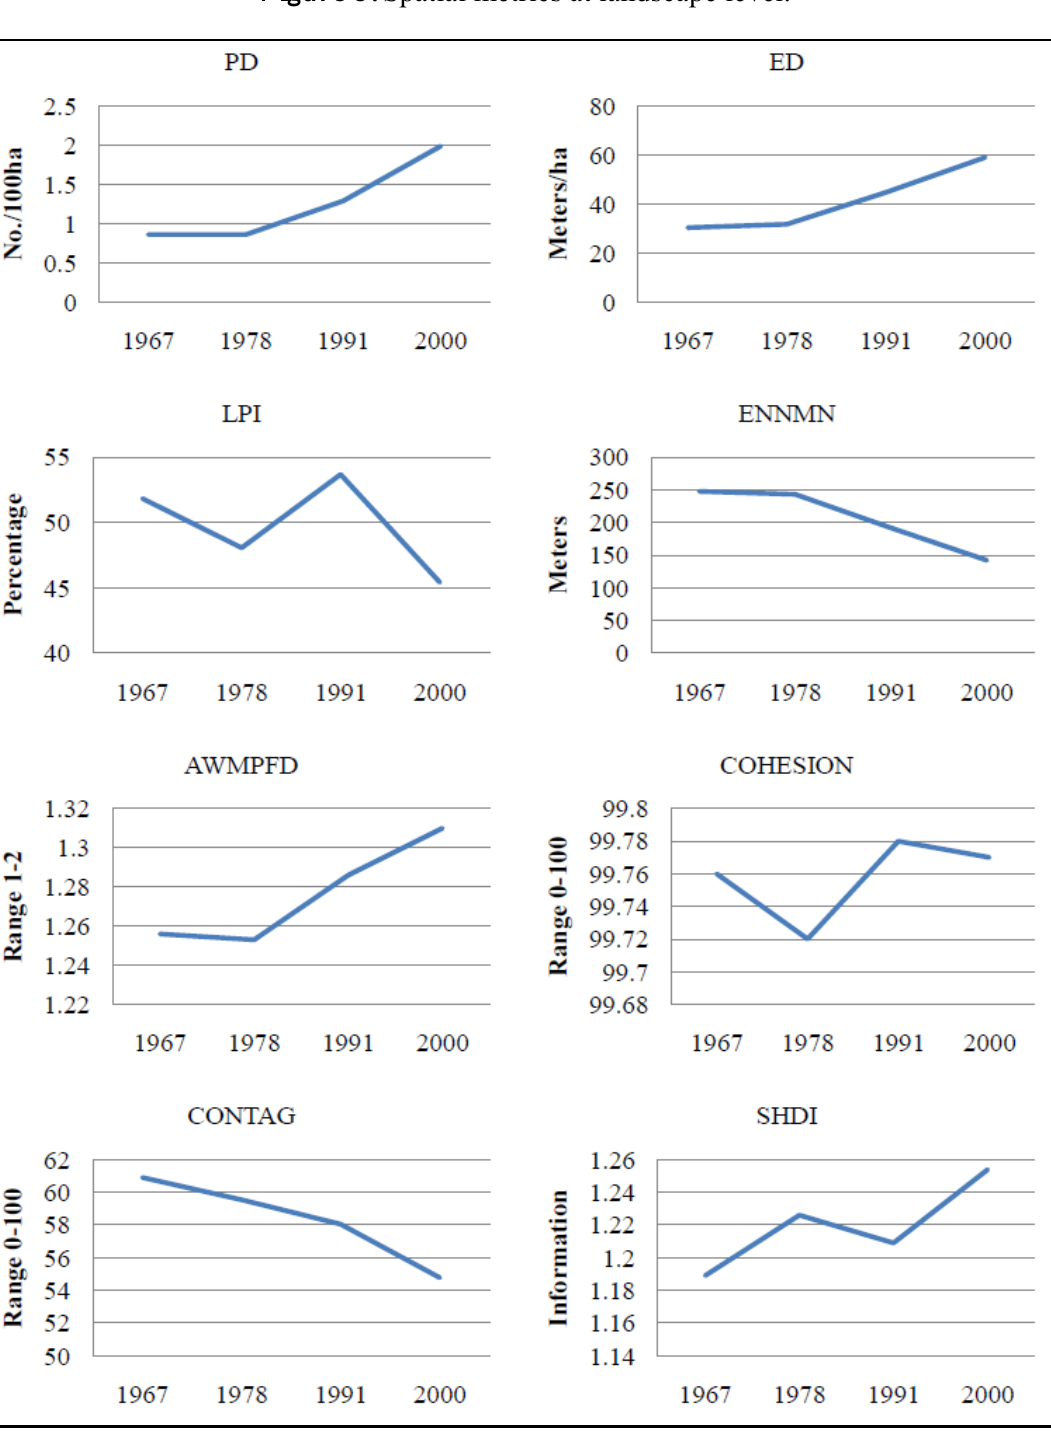
Figure 8. Spatial metrics at landscape